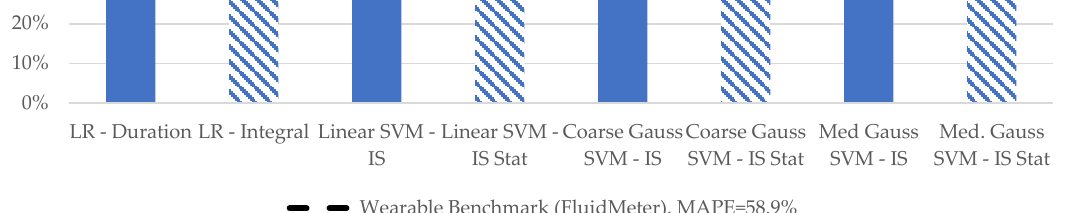
Figure 7. Variation in volume mean absolute percentage error for various models considered.